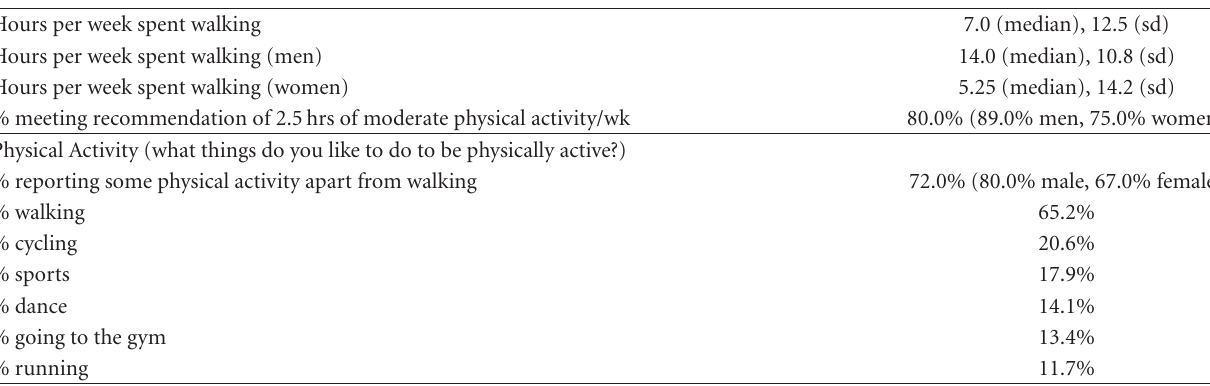
Table 2: Physical activity